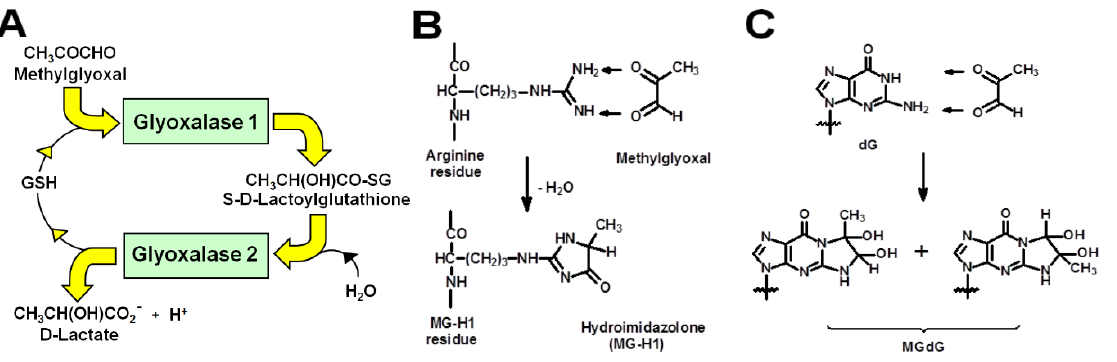
Figure 1. The glyoxalase system and protein and DNA glycation by methylglyoxal. ( A ) Metabolism of MG by the glyoxalase system. ( B ) Formation of hydroimidazolone MG-H1 from arginine residues. ( C ) Formation of imidazopurinone MGdG in DNA. Adduct residue is shown with guanyl base only.